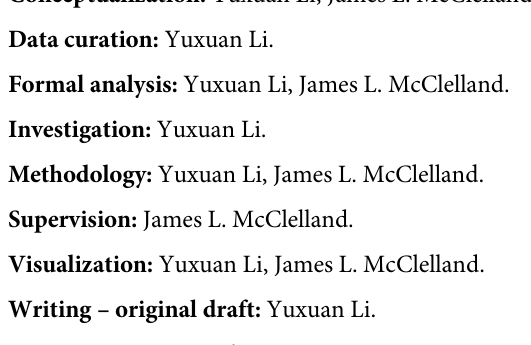
S4 Fig. Experiment 2 model-predicted response times (in red) and empirical response times (in blue). A . Base trials. B . Subgoal trials. Visualization and notations as in Fig 4C. (PDF) S5 Fig. Experiment 2 IA trial responses and drift-diffusion model fits for groups of higher and lower accuracy. Left panel, model parameter estimates. Middle panel, base trials. Right panel, subgoal trials. Visualization and notations as in Fig 6C and S4 Fig. (PDF) S6 Fig. Experiment 2 survey responses. Participants’ self-reported considerations of different task elements was in line with the behavioral analyses presented above. In free-form responses, when asked how they came up with the route to reach the goal, their responses consistently suggested that the reasoning process was rapid and intuitive. Likert scale: 1=never, 2=rarely, 3=sometimes, 4=often, 5=always. Sprite denotes the movable blue block. Error bars indicate bootstrapped 95% confidence limits.